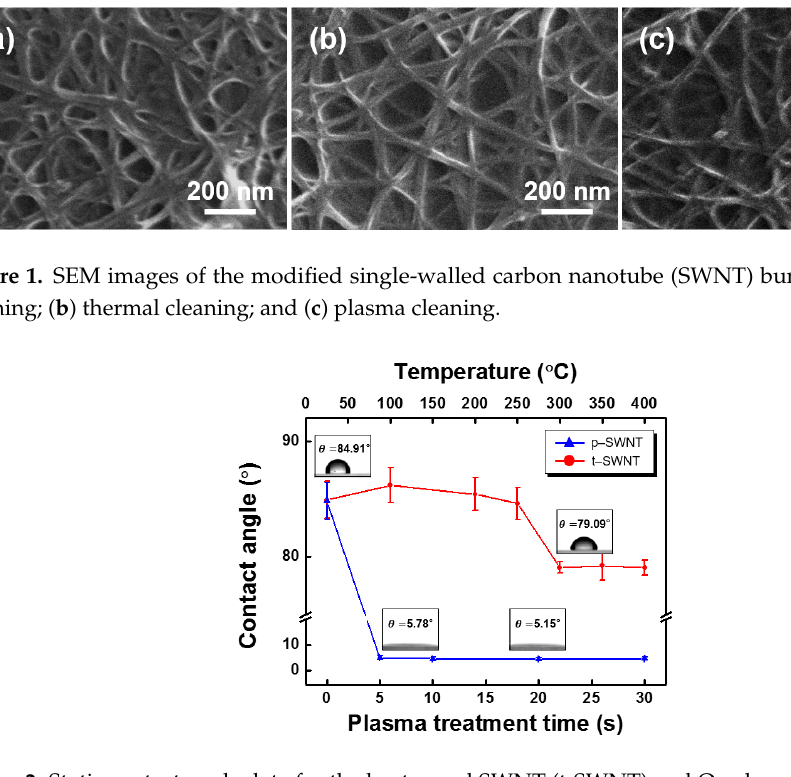
Figure 2. Static contact angle data for the heat-cured SWNT (t-SWNT) and O 2 plasma-treated SWNT (p-SWNT) at various conditions. Note that the p-SWNT shows much smaller standard deviation of the observed contact angle than the t-SWNT does.